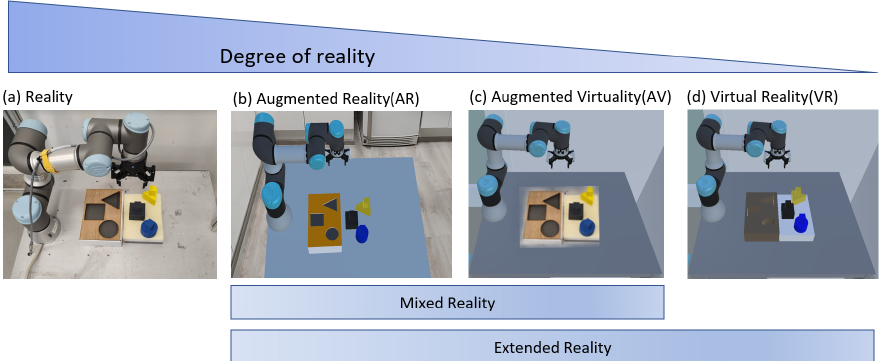
Figure 2. Reality–virtuality continuum. ( a ) real environment, ( b ) augmented virtuality, ( c ) augmented reality, and ( d ) virtual reality. The degree of reality decreases when moving from a real environment to virtual